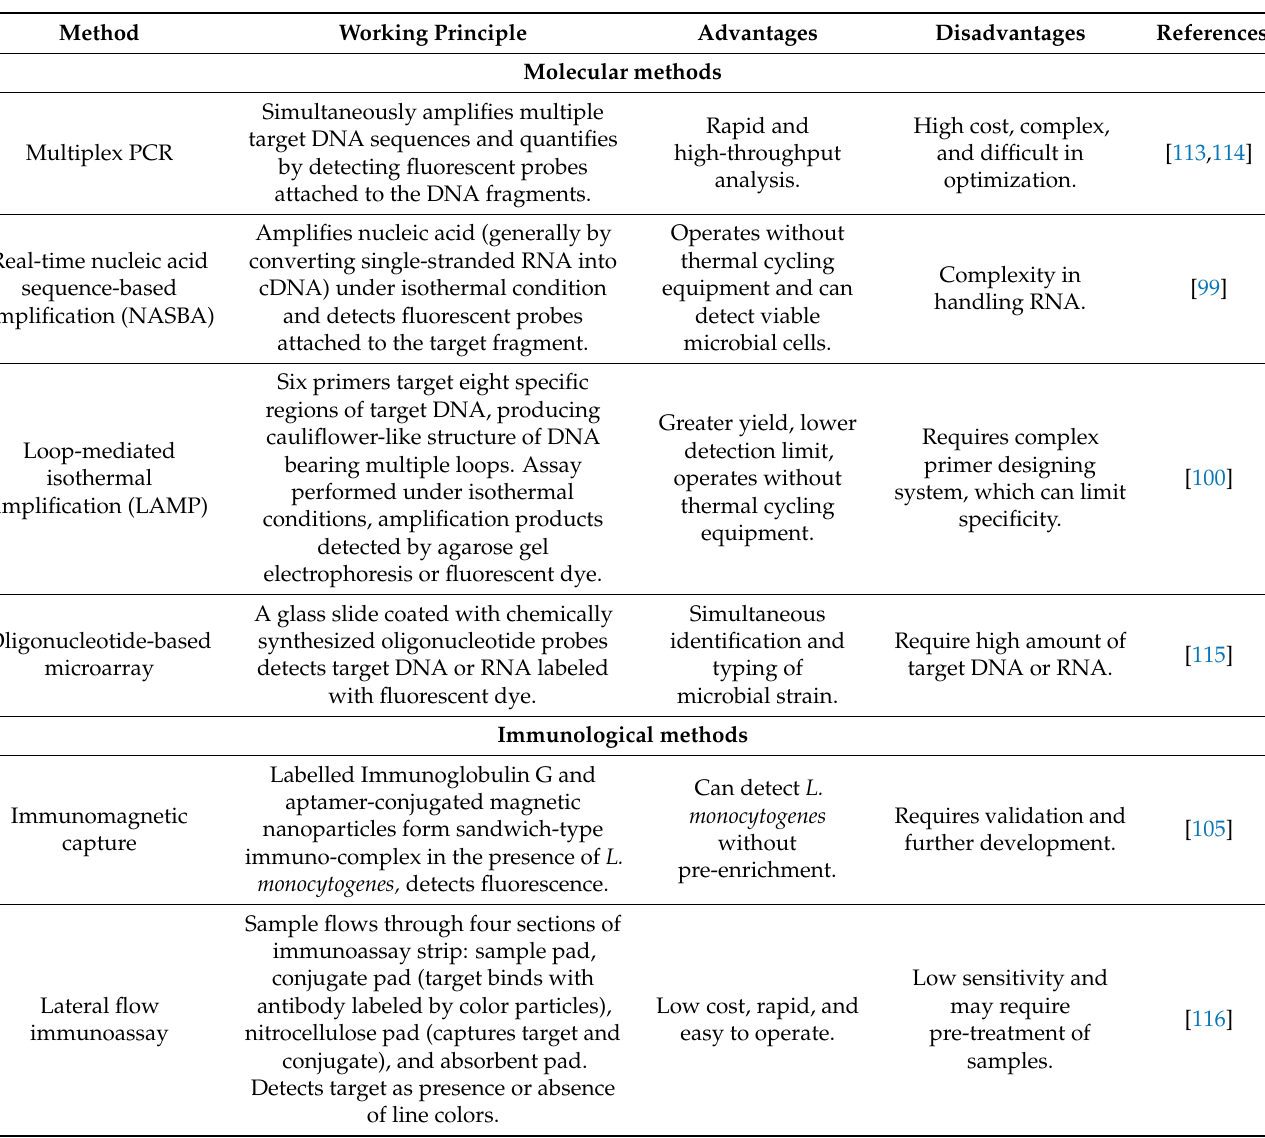
Table 2. An overview of rapid and novel methods for detection of Listeria and L. monocytogenes , categorized as molecular methods, immunological methods, biosensors, spectroscopic methods, microfluidic systems, and phage-based